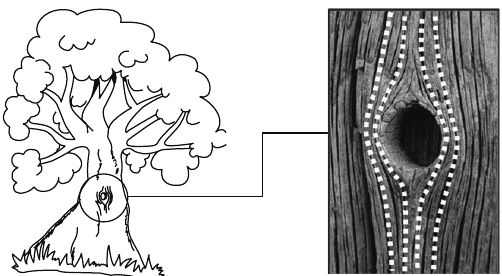
Figure 1: Reducing the stress concentration on knotholes of trees by load adjusted fiber orientation at the defect